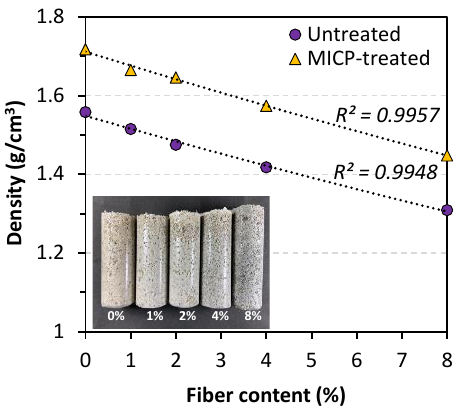
Figure 6. Comparison of sample density before and after MICP treatment.